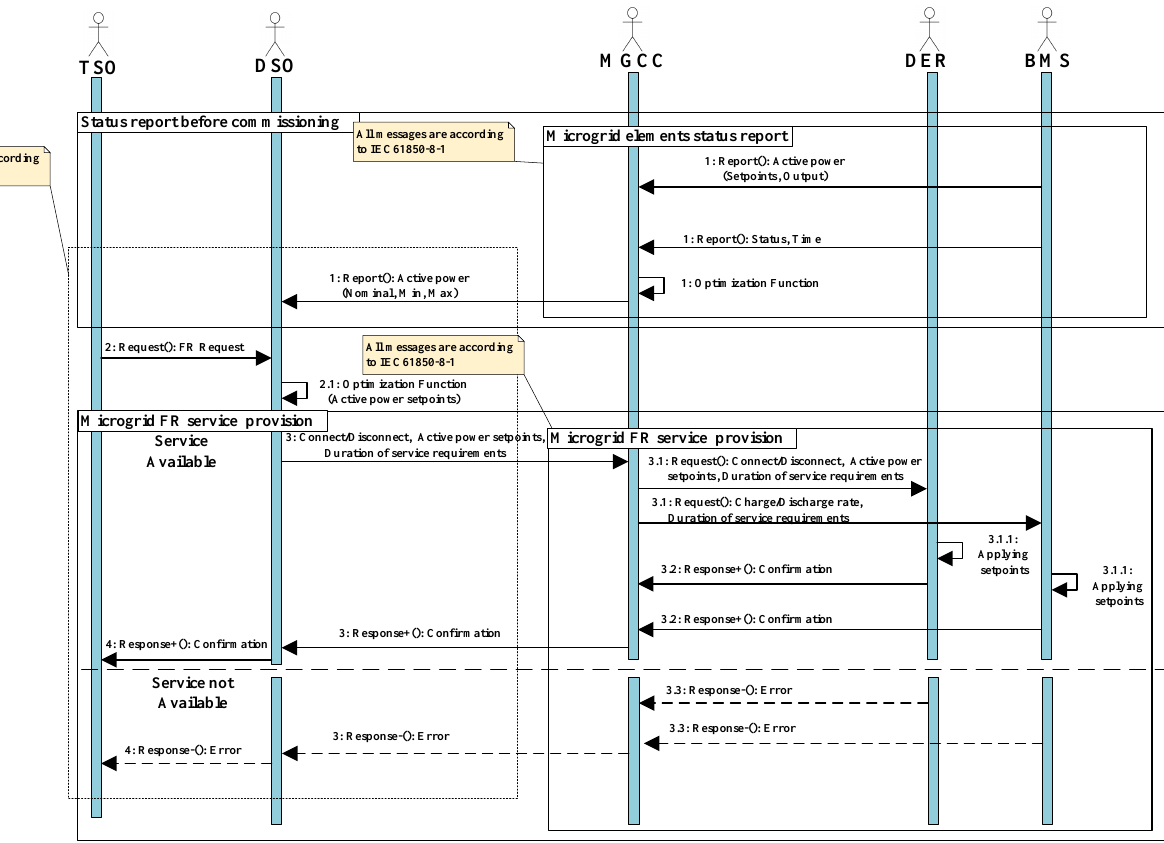
Figure 3. Sequence diagram of FR support from MG. The message format for interaction inside microgrid, which is LAN, is according to the IEC 61850–8–1 and IEC 61850–8–2 is used for communication in WAN, between the MGCC and the utility grid supervisory unit i.e.,